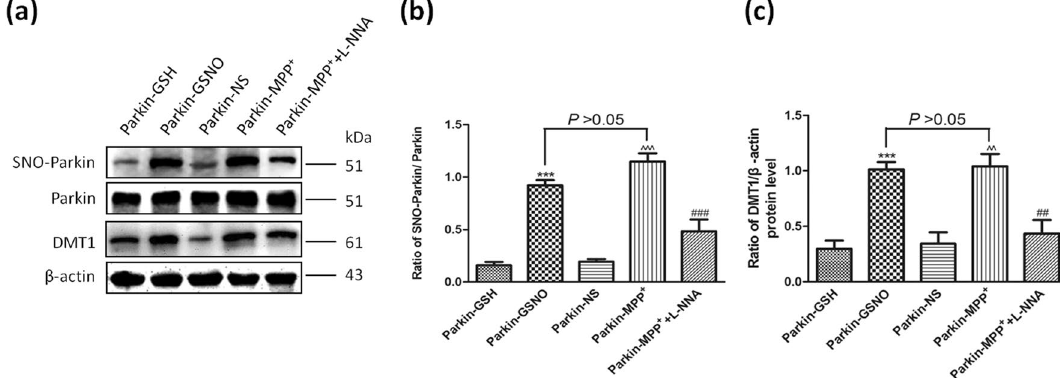
Figure 4. GSNO and MPP + increased the levels of S-nitrosylated parkin and DMT1 in parkin-transfected SH-SY5Y cells. ( a ) Changes of SNO-parkin and DMT1 protein levels following different treatment (200 μM of MPP + ; 200 μM of GSNO; 200 μM of MPP + + 1 mM of L-NNA) for 24 h in parkin-transfected SH-SY5Y cells. ( b ) Statistical analysis for changes in levels of SNO-parkin. Data were presented as the ratio of SNO-parkin/parkin. *** P = 0.0002, parkin-GSNO versus parkin-GSH; ^^^ P = 0.0002, parkin-MPP + versus parkin-NS; ### P = 0.0004, parkin-MPP + + L-NNA versus parkin-MPP + ; P = 0.0541, parkin-MPP + versus parkin-GSNO. ( c ) Statistical analysis for changes in levels DMT1. Data were presented as the ratio of DMT1/β-actin. GSNO treatment acted as a positive control for MPP + treatment. *** P = 0.0004, parkin-GSNO versus parkin-GSH; ^^ P = 0.0027, parkin- MPP + versus parkin-NS; ## P = 0.0081, parkin-MPP + + L-NNA versus parkin-MPP + ; P = 0.847, parkin-MPP + versus parkin-GSNO. N =